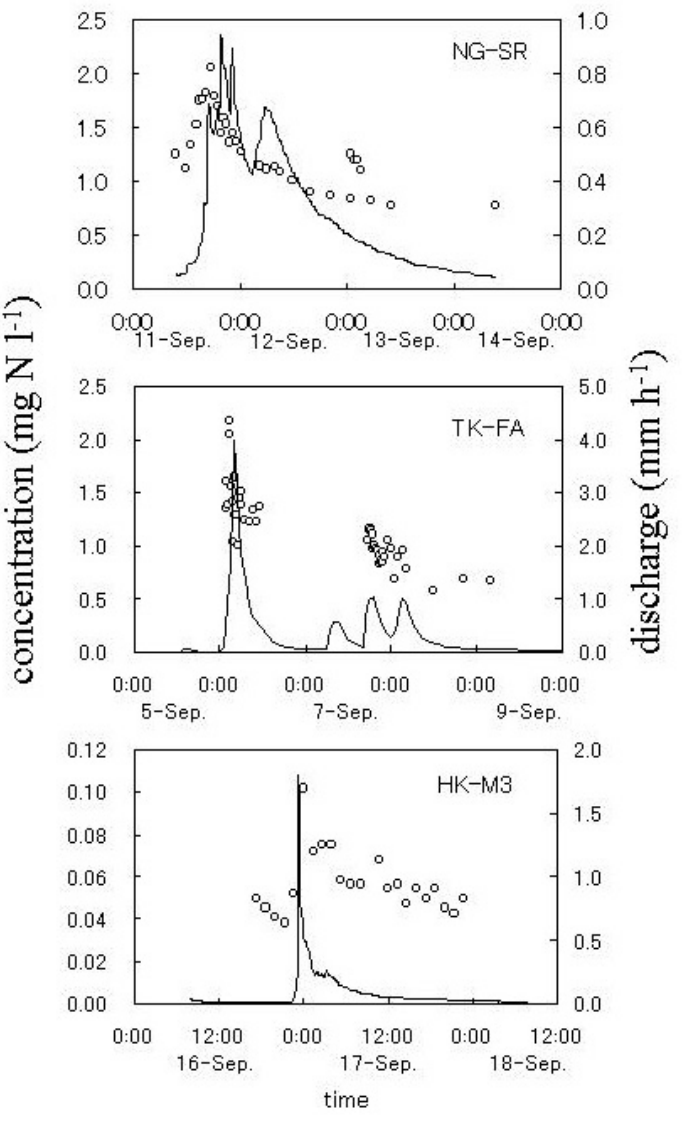
FIGURE 6 . Temporal fluctuation in stream nitrate concentrations (open circles) and discharge (lines) during a storm in September 2000 at NG-SR (top), TK-FA (middle), and HK-M3